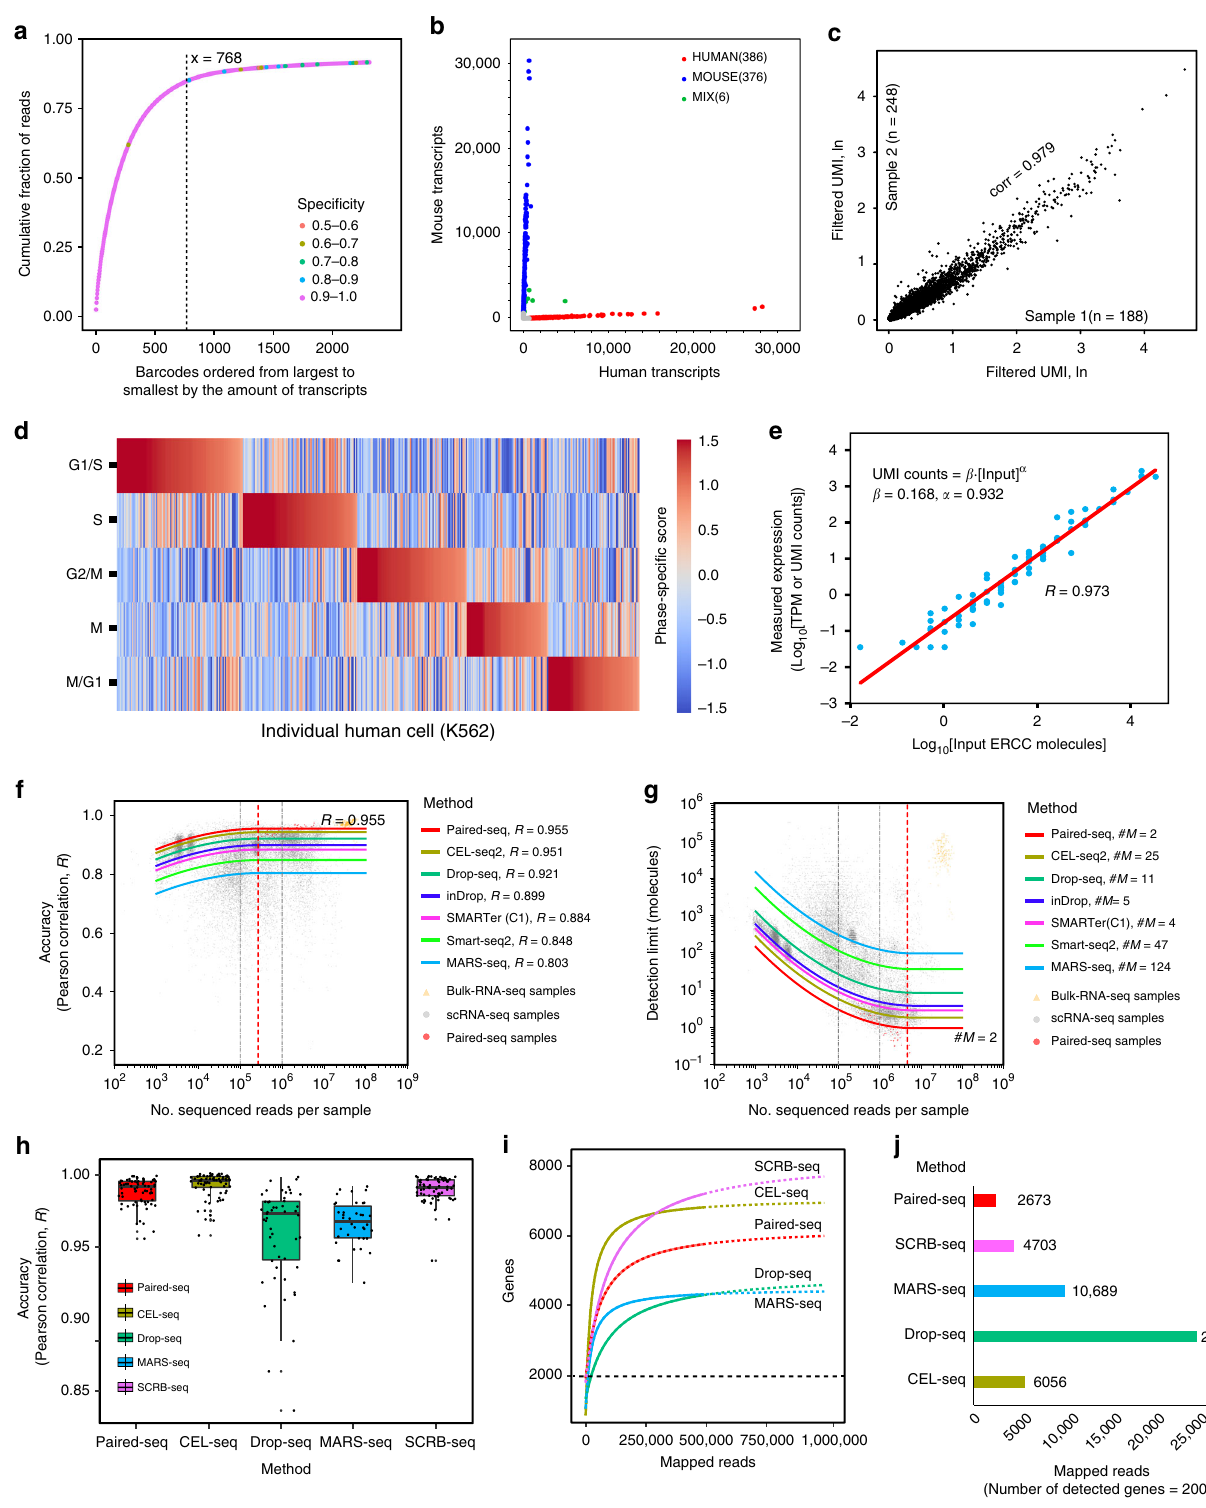
those of Drop-seq (12.8% and 47%), respectively 13 . Considering a global effect of sequencing depth, we also used a linear model, including an individual corrected performance parameter for each platform that could be ranked to account for the sequencing depth 34 . According to the model, we found that Paired-seq had the highest accuracy ( R = 0.955) for ERCC detection (Fig. 4f) among 16 different kinds of scRNA-seq platforms (Fig. 4f and